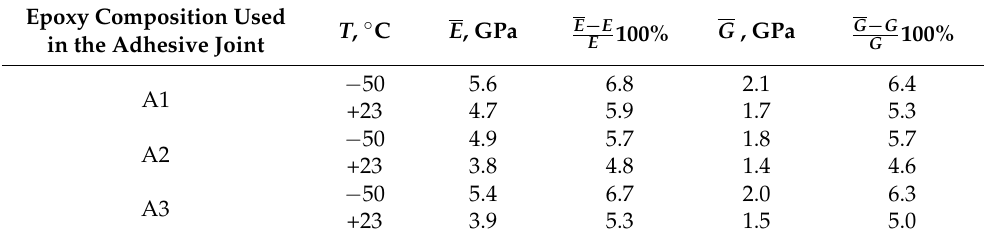
Table 3. The effective characteristics of the elastic properties of the selected microvolume. Epoxy Composition Used in the Adhesive